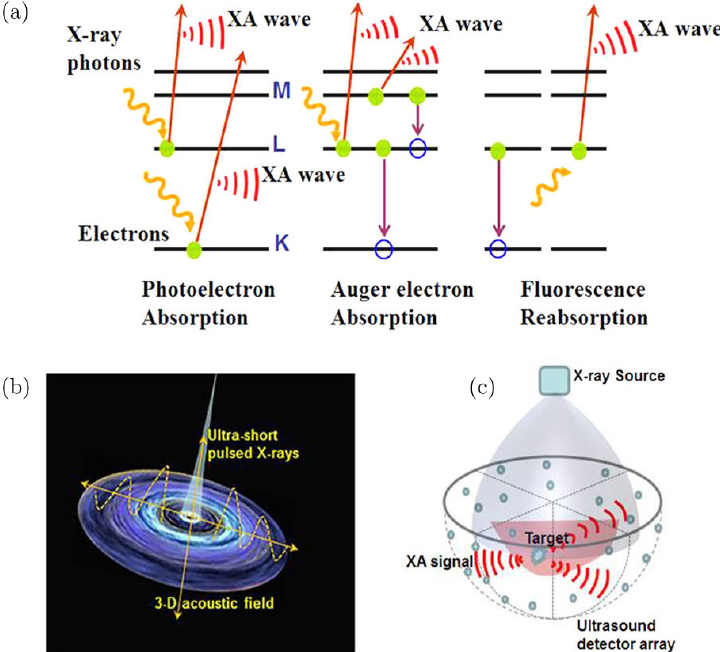
Fig. 1. (a) Schematic of the main processes which contribute to XA signals. M, L and K represent the electron shells around an atom's nucleus. (b) Schematic of the 3D acoustic ¯eld generated by ultrashort-pulsed X-rays. (c) Schematic diagram of 3D XACT. (Fig. 1 of Ref.